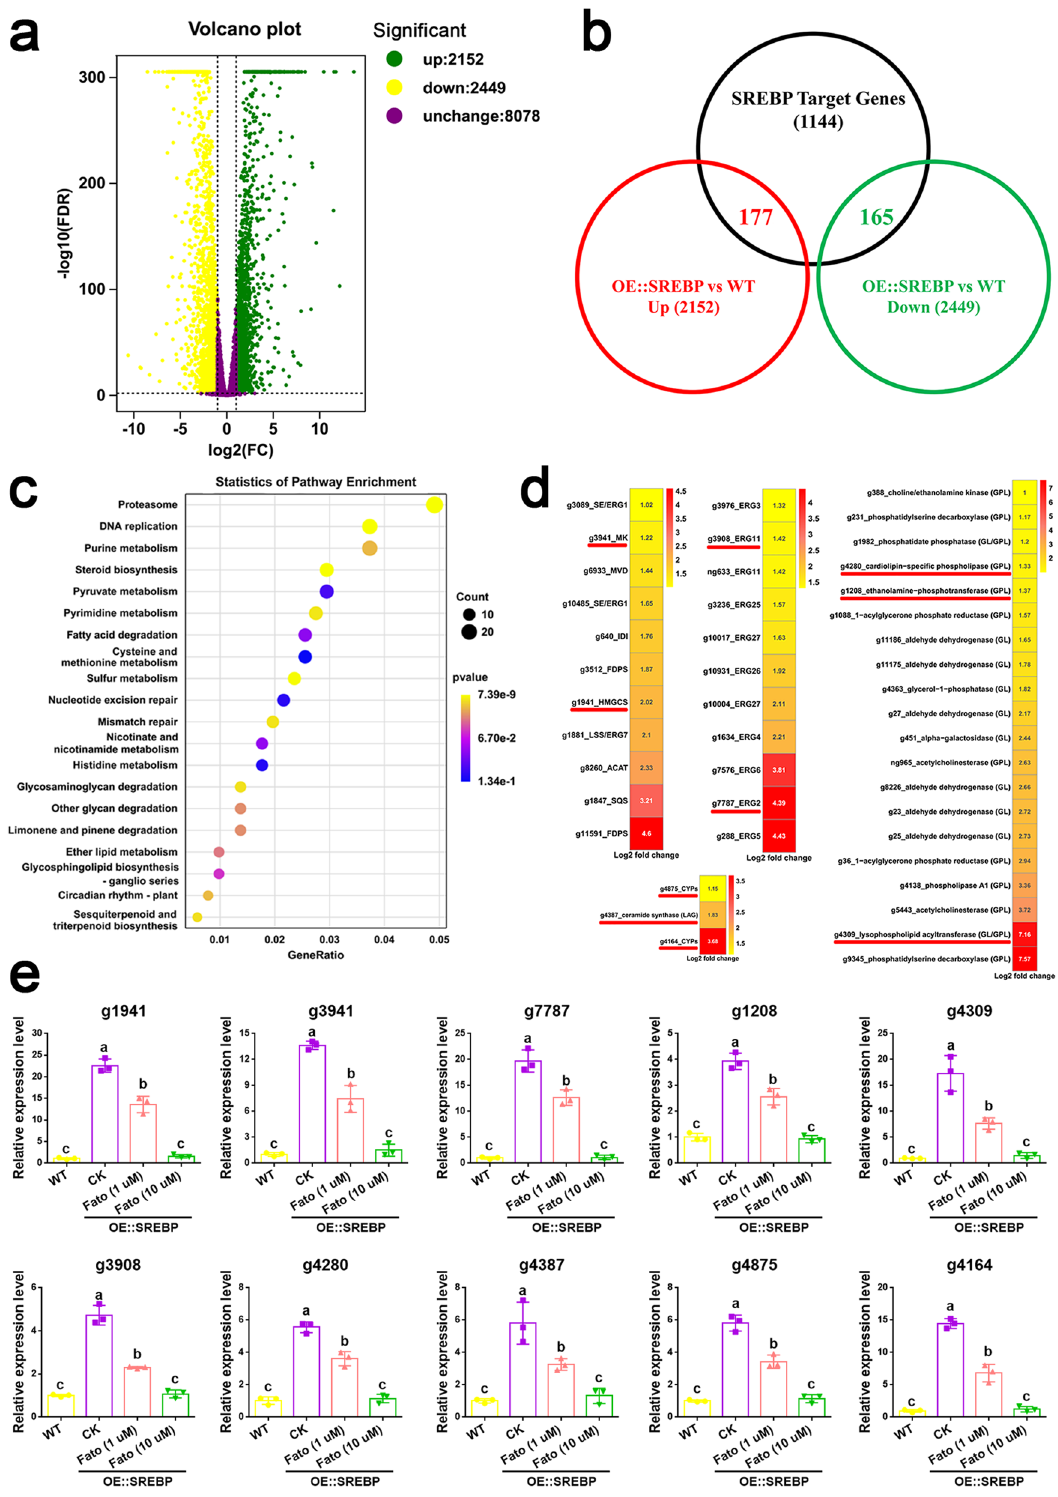
Data 8). Speci fi cally, 22 upregulated DEGs were involved in steroid and triterpenoid biosynthesis, in which 11 DEGs involved in the MVA pathway, such as squalene synthase ( g1847 ), lanosterol synthase ( g1881 ), and SREBP targets 3-hydroxy-3- methylglutaryl CoA synthetase (g1941 ) and mevalonate kinase ( g3941 ), and the other eleven ERGs, such as delta 24-sterol reductase (ERG4, g1634 ) and sterol 22-desaturase (ERG5, g288 ),